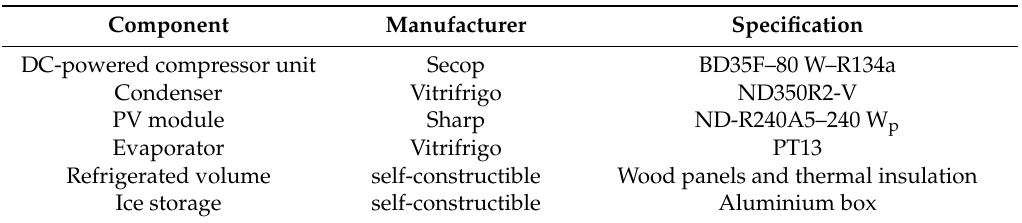
Figure 1. General structure of the system. Table 2. Technical